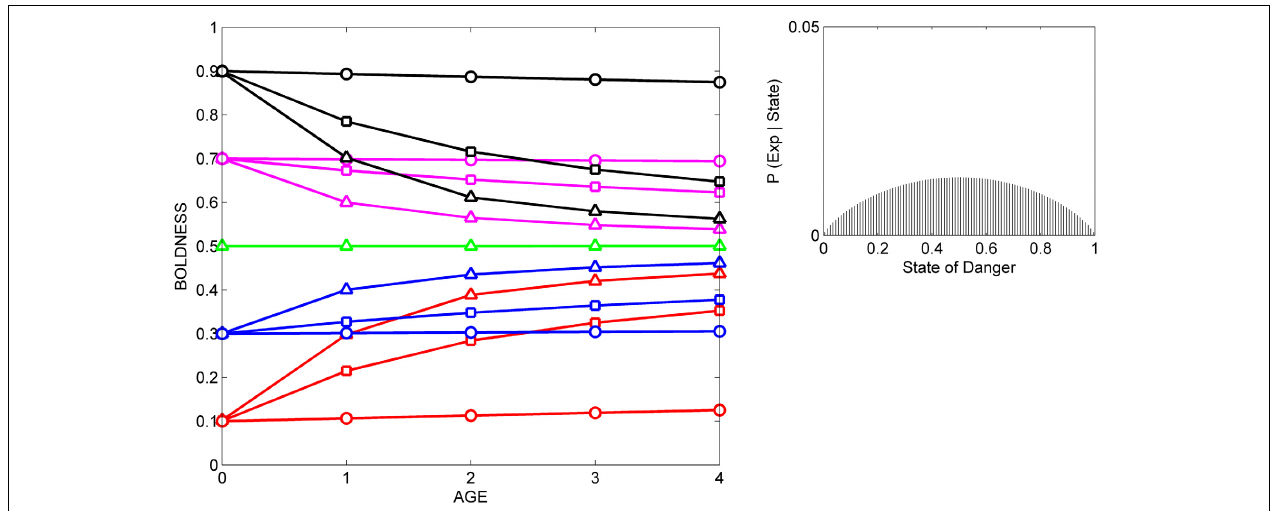
FIGURE 4 | Developmental trajectories for boldness resulting from repeated exposure to a moderately reliable cue indicative of intermediate levels of danger. Symbols for prior distributions as in Figure 2 . The likelihood function (right box) was generated by a beta distribution with α = 1 . 75 and β = 1 .